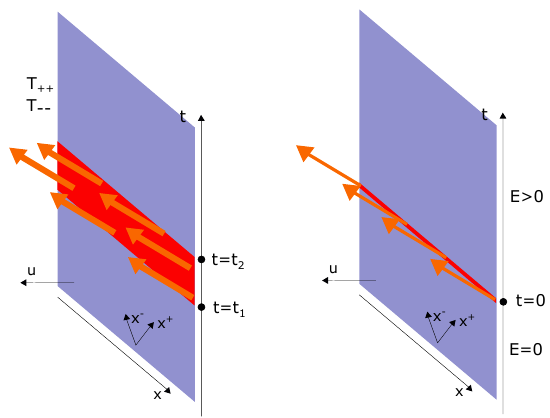
Figure 6 . Left: classical injection of bulk energy between t 1 < t < t 2 . We consider the region after the injection takes place t > t 2 where a non-zero boundary T (cid:6)(cid:6) was generated. Right: classical injection of a translationally symmetric pulse into the